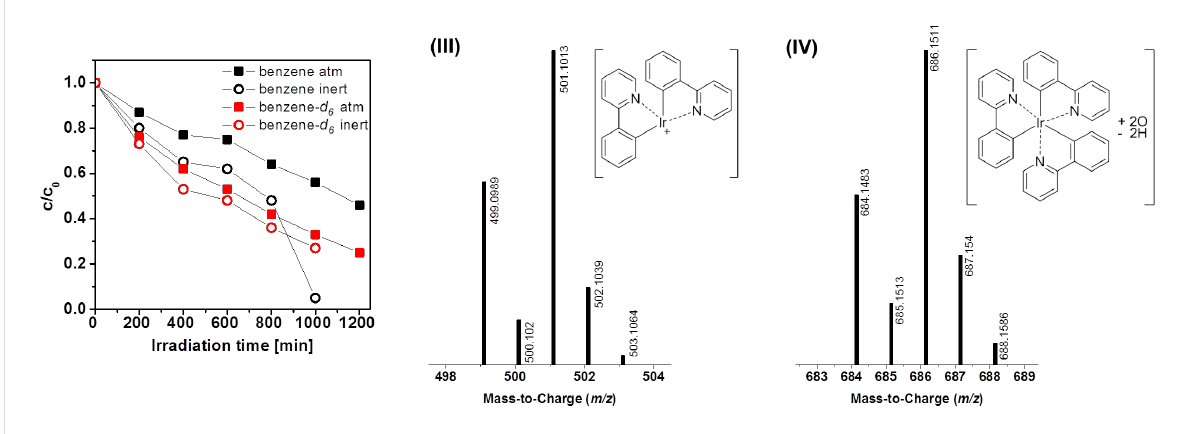
Figure 7: Degradation curves of Ir(ppy) 3 in benzene and benzene- d 6 under ambient and inert conditions, and mass spectra of two degradation prod- ucts with the assigned structures.